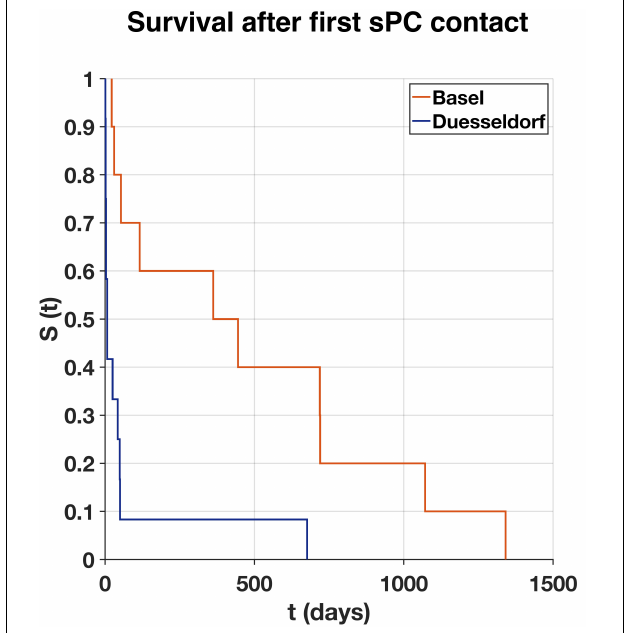
FIGURE 3 | Survival rate (S) over time (t) of first specialist Palliative Care (sPC) contact to death in days as estimated according to the Kaplan-Meier method for Basel (orange, n = 10) and Duesseldorf (blue, n = 12). Median survival in Basel 404 days, in Duesseldorf seven days (log-rank test: p < 0.01).